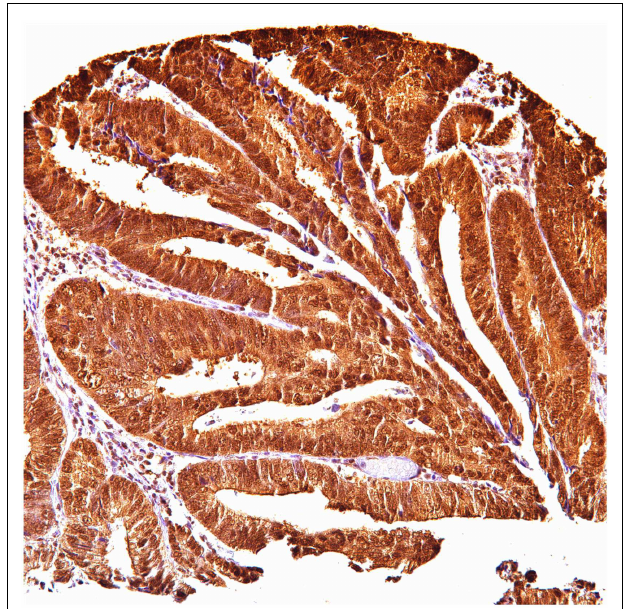
FIGURE 3 | Ubiquitin cytoplasmic positive in colon carcinoma .